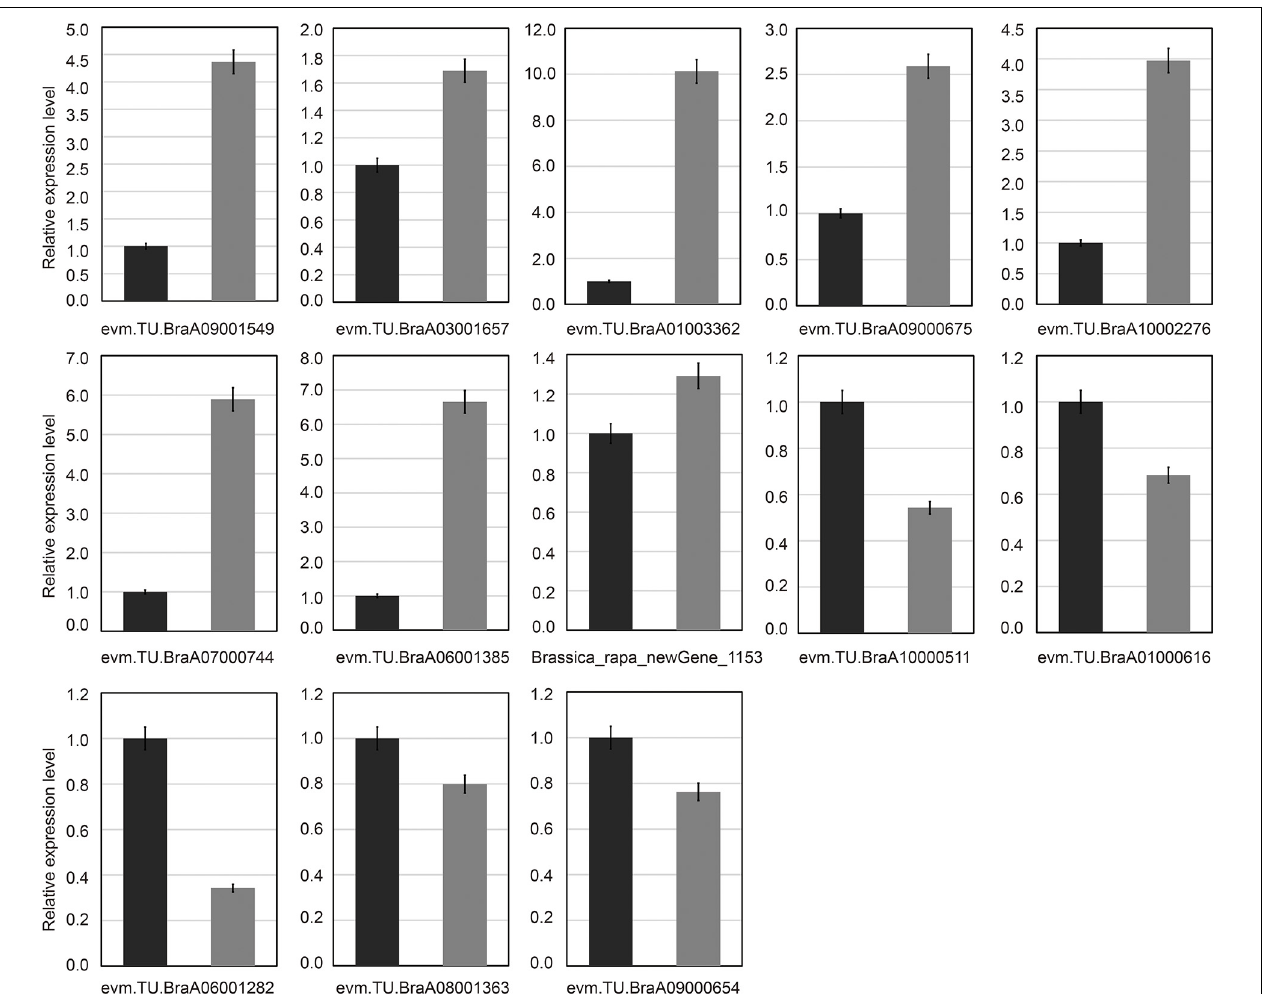
FIGURE 7 | Verification of common differentially expressed genes by quantitative real-time polymerase chain reaction (qRT-PCR). Thirteen common differentially expressed genes (DEGs) were chosen for qRT-PCR validation. The relative expression levels of each gene were expressed as the fold change between BcL.1-25 (black column) and BcL.1-4 (gray